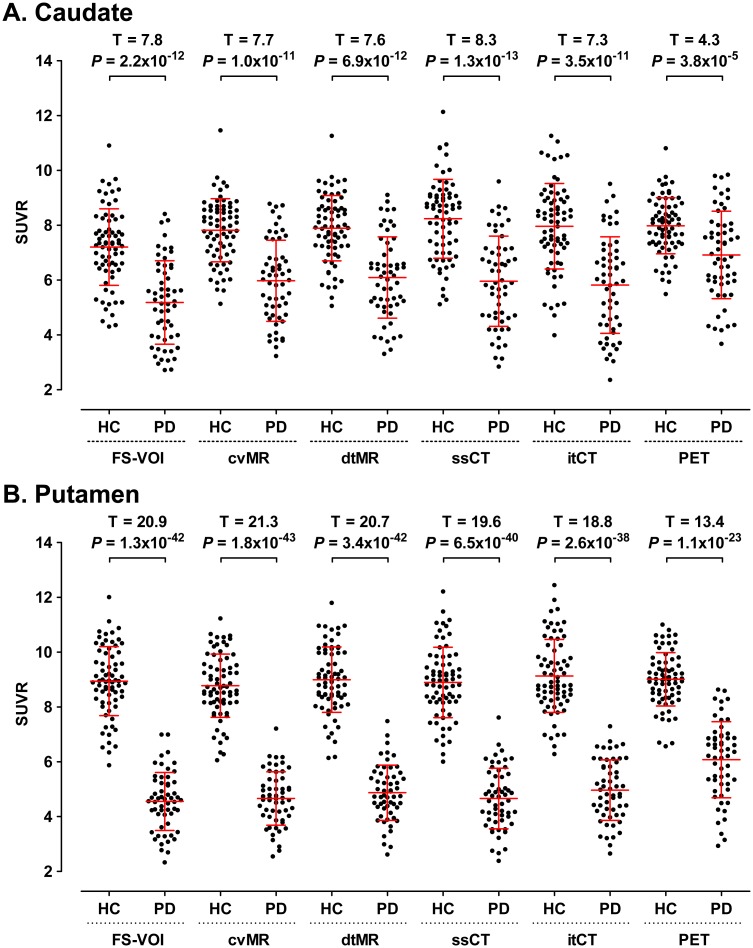
Striatal standardized uptake value ratio (SUVR) values (A: caudate, B: putamen) of healthy controls (HC) and Parkinson’s disease (PD) patients.The horizontal red bars represent mean and standard deviation (SD). T- and P-values for comparing two groups with independent t-test are presented on the top of the graphs. Abbreviations: FSVOI = FreeSurfer-generated volume of interest, cvMR = MR-guided spatial normalization with conventional normalization tool, dtMR = MR-guided spatial normalization with DARTEL toolbox, ssCT = skull-stripped CT-guided spatial normalization, itCT = intensity transformed CT-guided spatial normalization, PET = PET-guided spatial normalization.